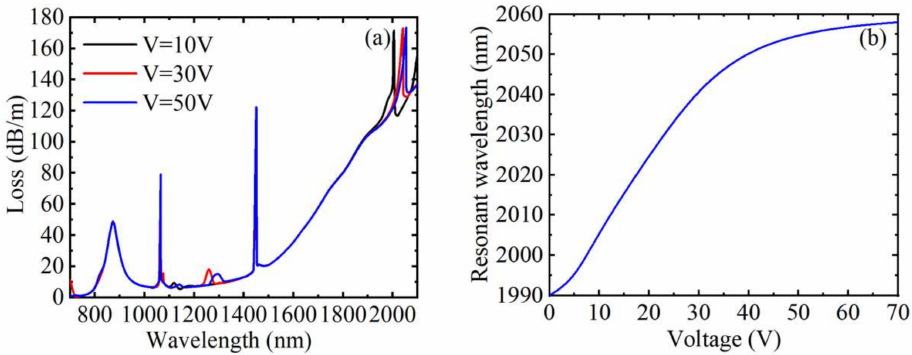
Figure 5. When n = 1.41, T = 20 ◦ C, and H = 250 Oe, under different voltages, ( a ) the loss spectrum of the core guide mode, ( b ) the variation relationship between the resonance wavelength corresponding to peak 4 and the